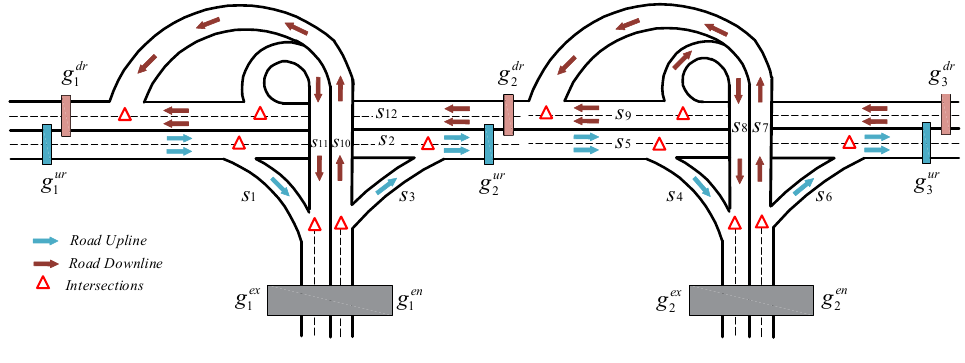
Figure 1. A simple road network.